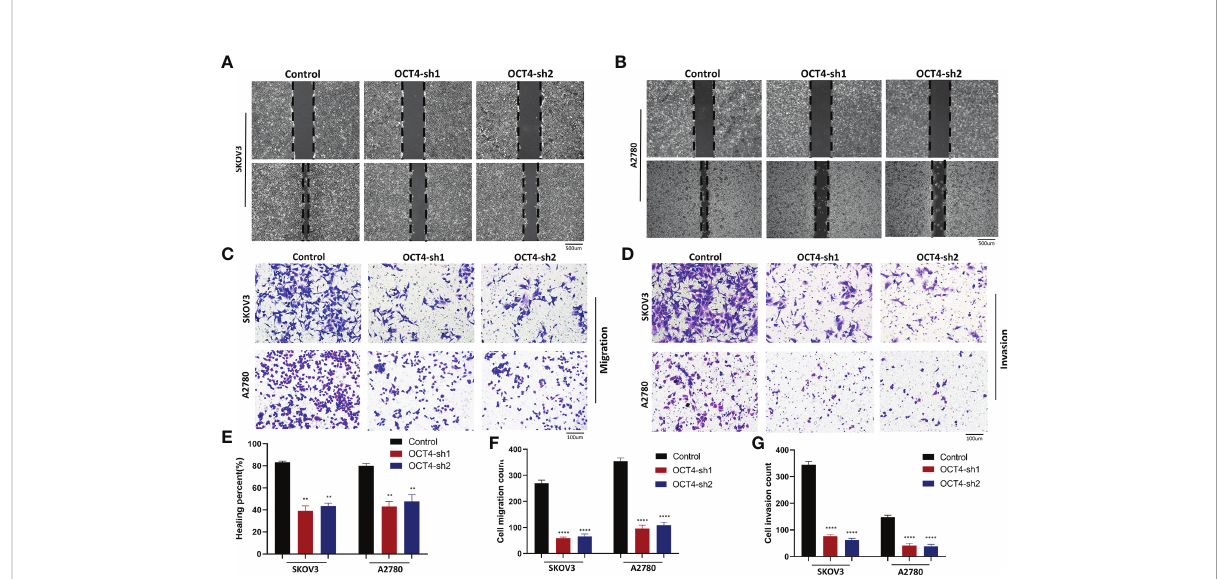
FIGURE 4 Knockdown of OCT4 inhibited the migration and invasion of OC cells (A, B) In two cell lines, wound healing assays indicated the percent of wounds closed. (C, D) Transwell assays were used to measure the migration and invasion of two cell lines. (E – G) Quanti fi cation of cell migration and invasion was measured by wound healing or Transwell assays. (Data were expressed as the mean ± SD. Signi fi cance was calculated using Student ’ s t-test. **P<0.01,